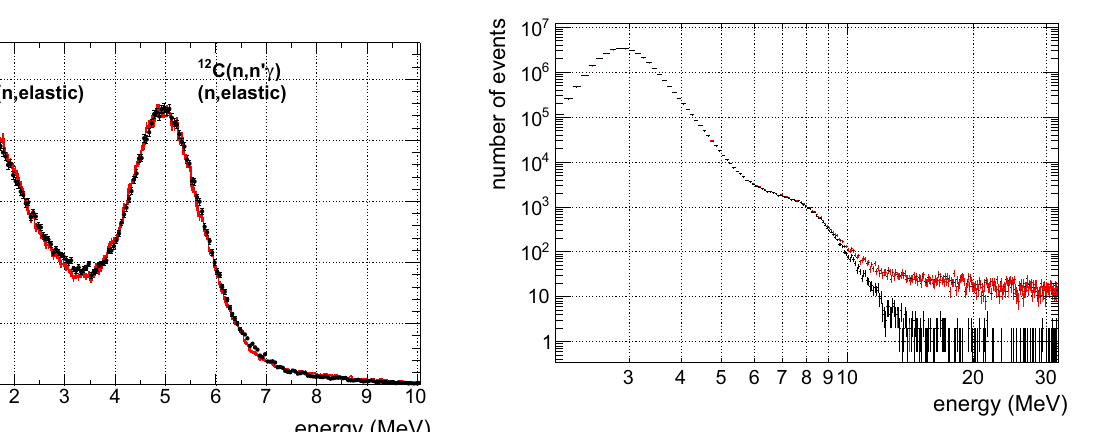
Fig. 5 Energy spectrum of all the trigger pulses (red line), pulses not tagged as muon (black